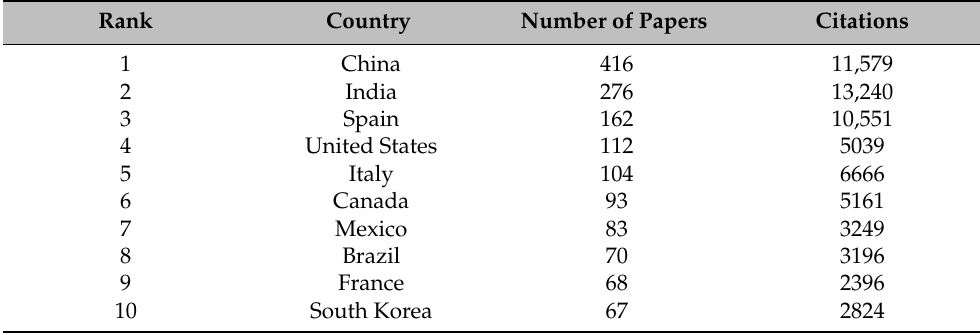
Table 4. Top 10 countries of the authors’ affiliation of published articles reporting on laccase–assisted wastewater treatment.